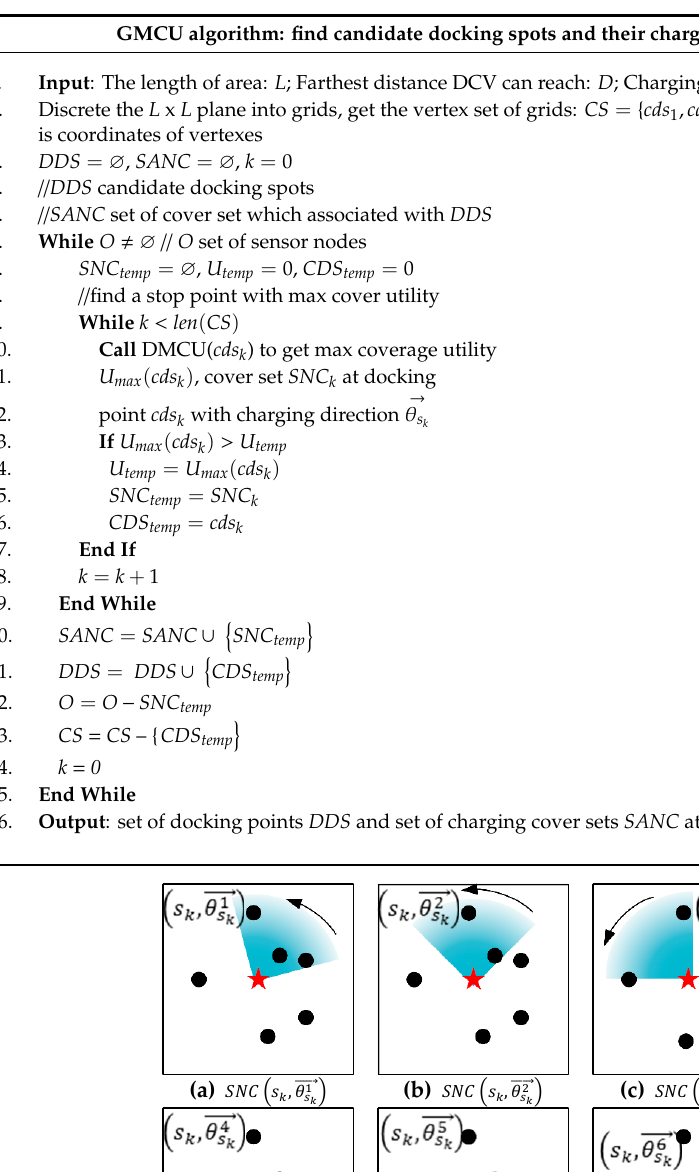
Table 2. The Procedure of the GMCU (Greedy approximation algorithm of Maximum Coverage Utility) Algorithm.